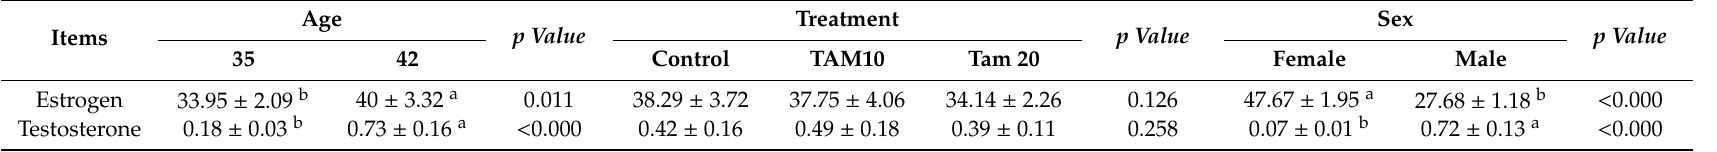
Table 6. The e ff ect of age, Tamoxifen treatment and sex on serological oestrogen (pg / mL) and testosterone (ng / mL) concentrations in broiler chickens (Means ± SE). Items